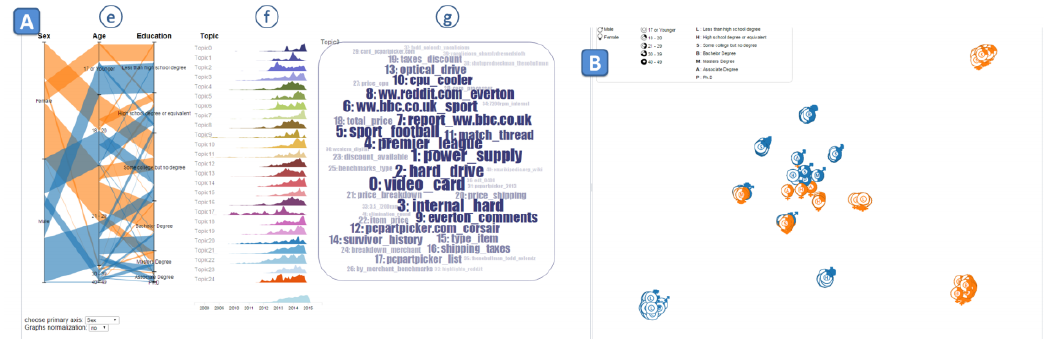
Figure 21. ( a ) Parallel set + word cloud visualisation; and ( b ) the User Cluster visualisation. Image courtesy of Dou et al. [32].